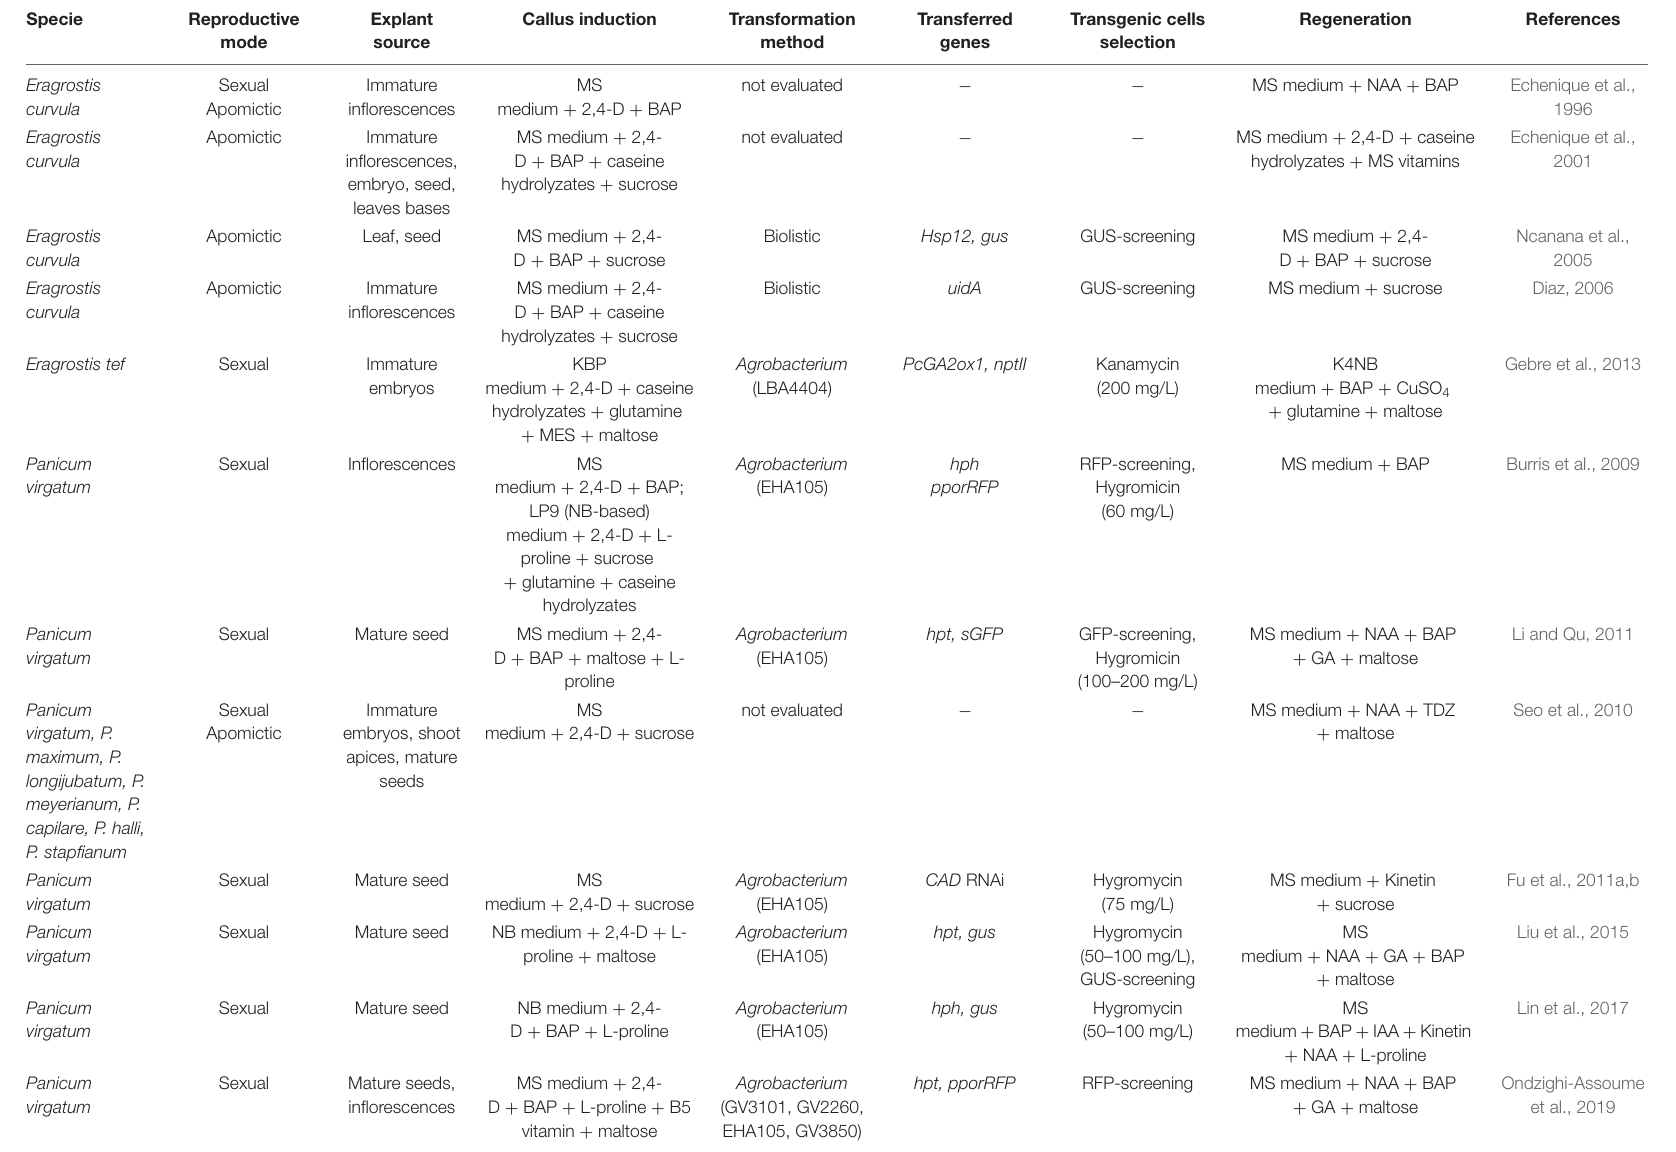
TABLE 1 | Summary of methods for in vitro culture, transformation and regeneration of apomictic grasses and their relatives.